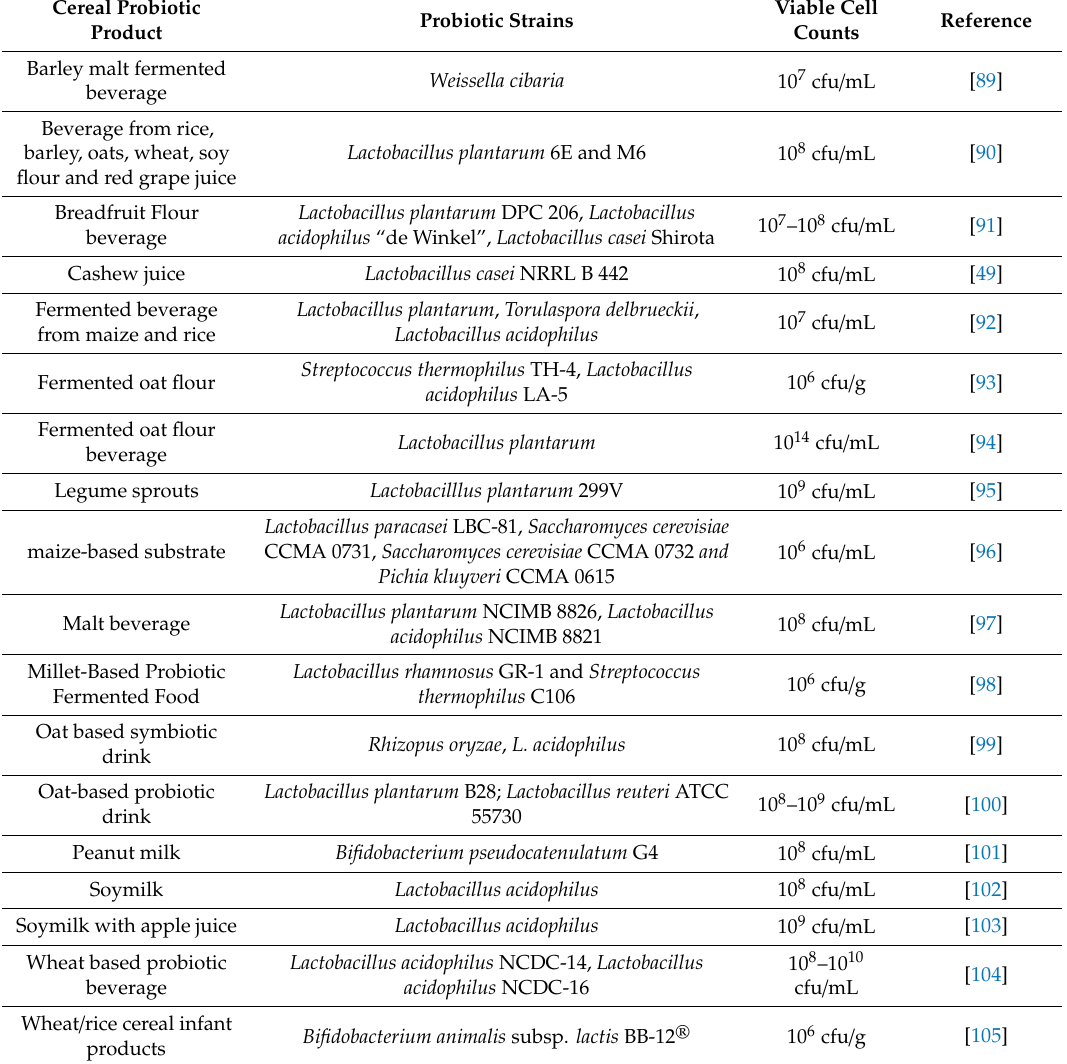
Table 4. Examples of cereal probiotic